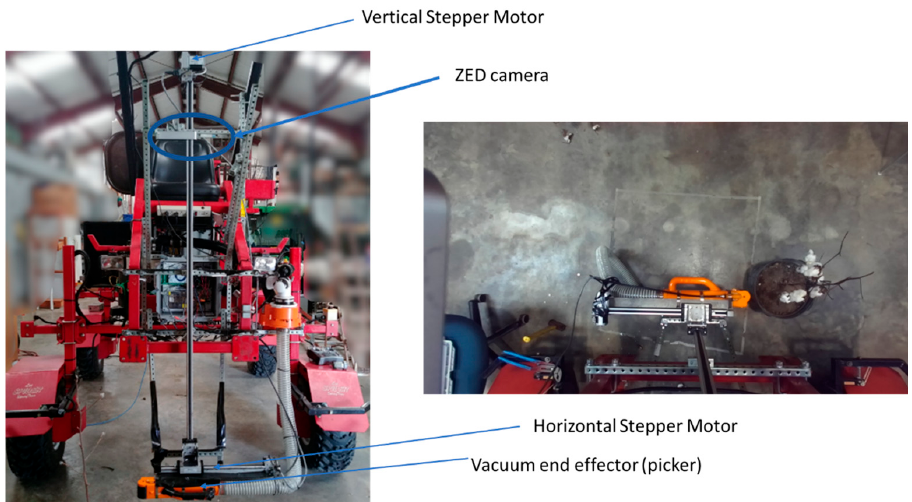
Figure 1. Left image: cotton-harvesting robot view from the front, which shows the ZED camera facing down. Right right: sample image obtained by the ZED camera that shows cotton manipulator and potted cotton plant with bolls.